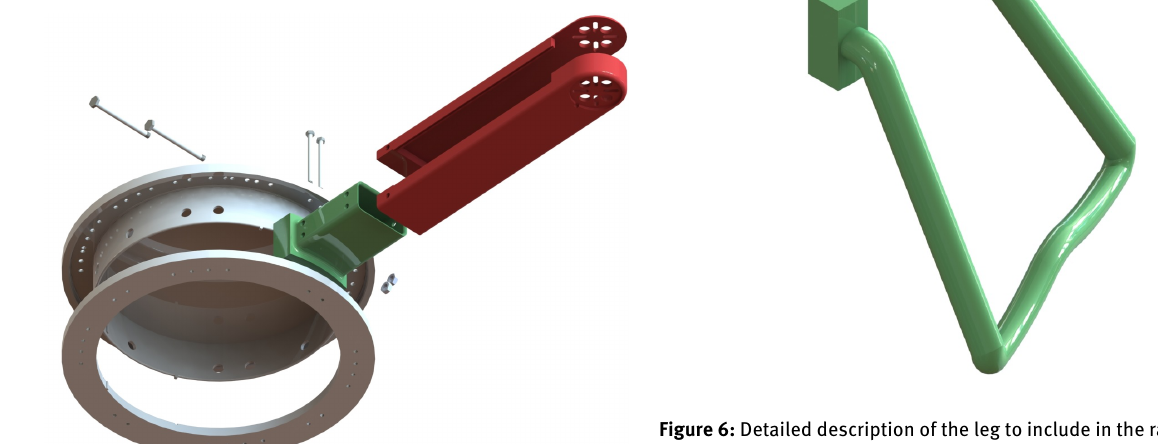
Figure 6: Detailed description of the leg to include in the